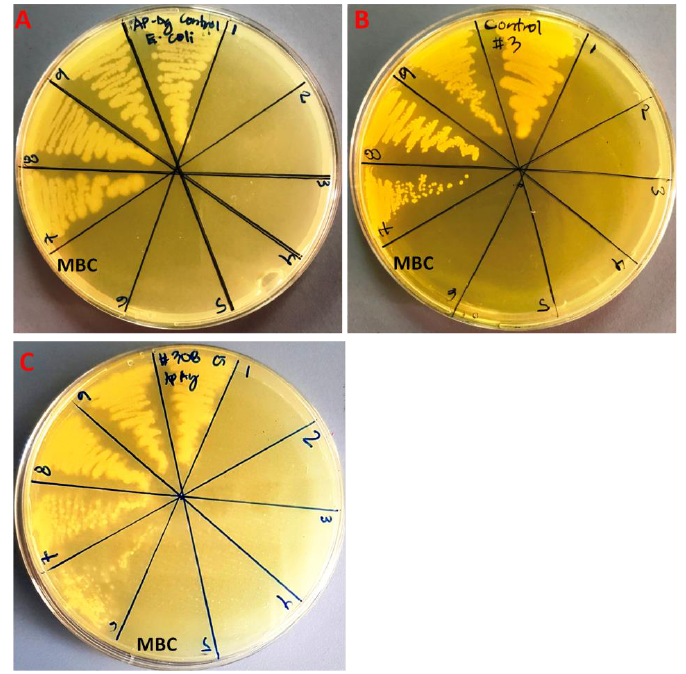
Figure 6. Nutrient agar plates showing MBC values of AP-AgNPs against Gram-negative bacteria. ( A ) E. coli (ATCC 25922), ( B ) multidrug-resistant Pseudomonas aeruginosa , and ( C ) multidrug-resistant Acinetobacter baumannii . Note: Block 1, 2, 3, 4, 5, 6, 7, 8 and 9 represents the concentration of AP-AgNPs i.e., 5, 2.5, 1.25, 0.625, 0.3125, 0.15625, 0.078125, 0.039 and 0.019 mg/mL, respectively, while 10 represents the control (untreated bacteria).